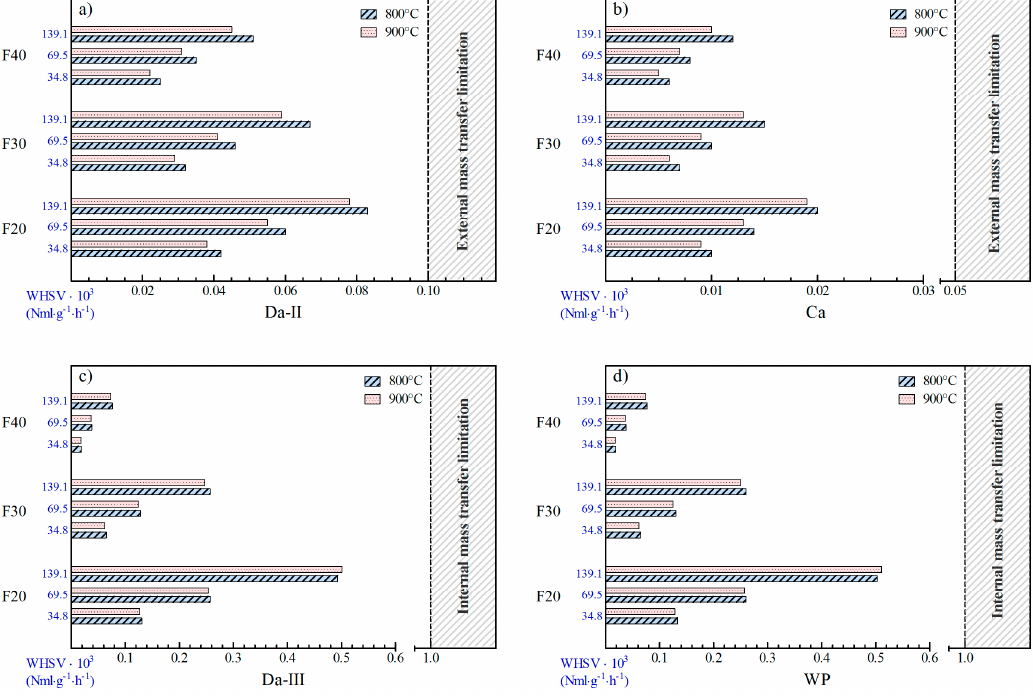
Figure 8. Influence of temperature and space velocity on ( a ) Da-II , ( b ) Ca , ( c ) Da-III and ( d ) WP dimensionless numbers on biogas SR experiments over F20, F30 and F40 catalysts.